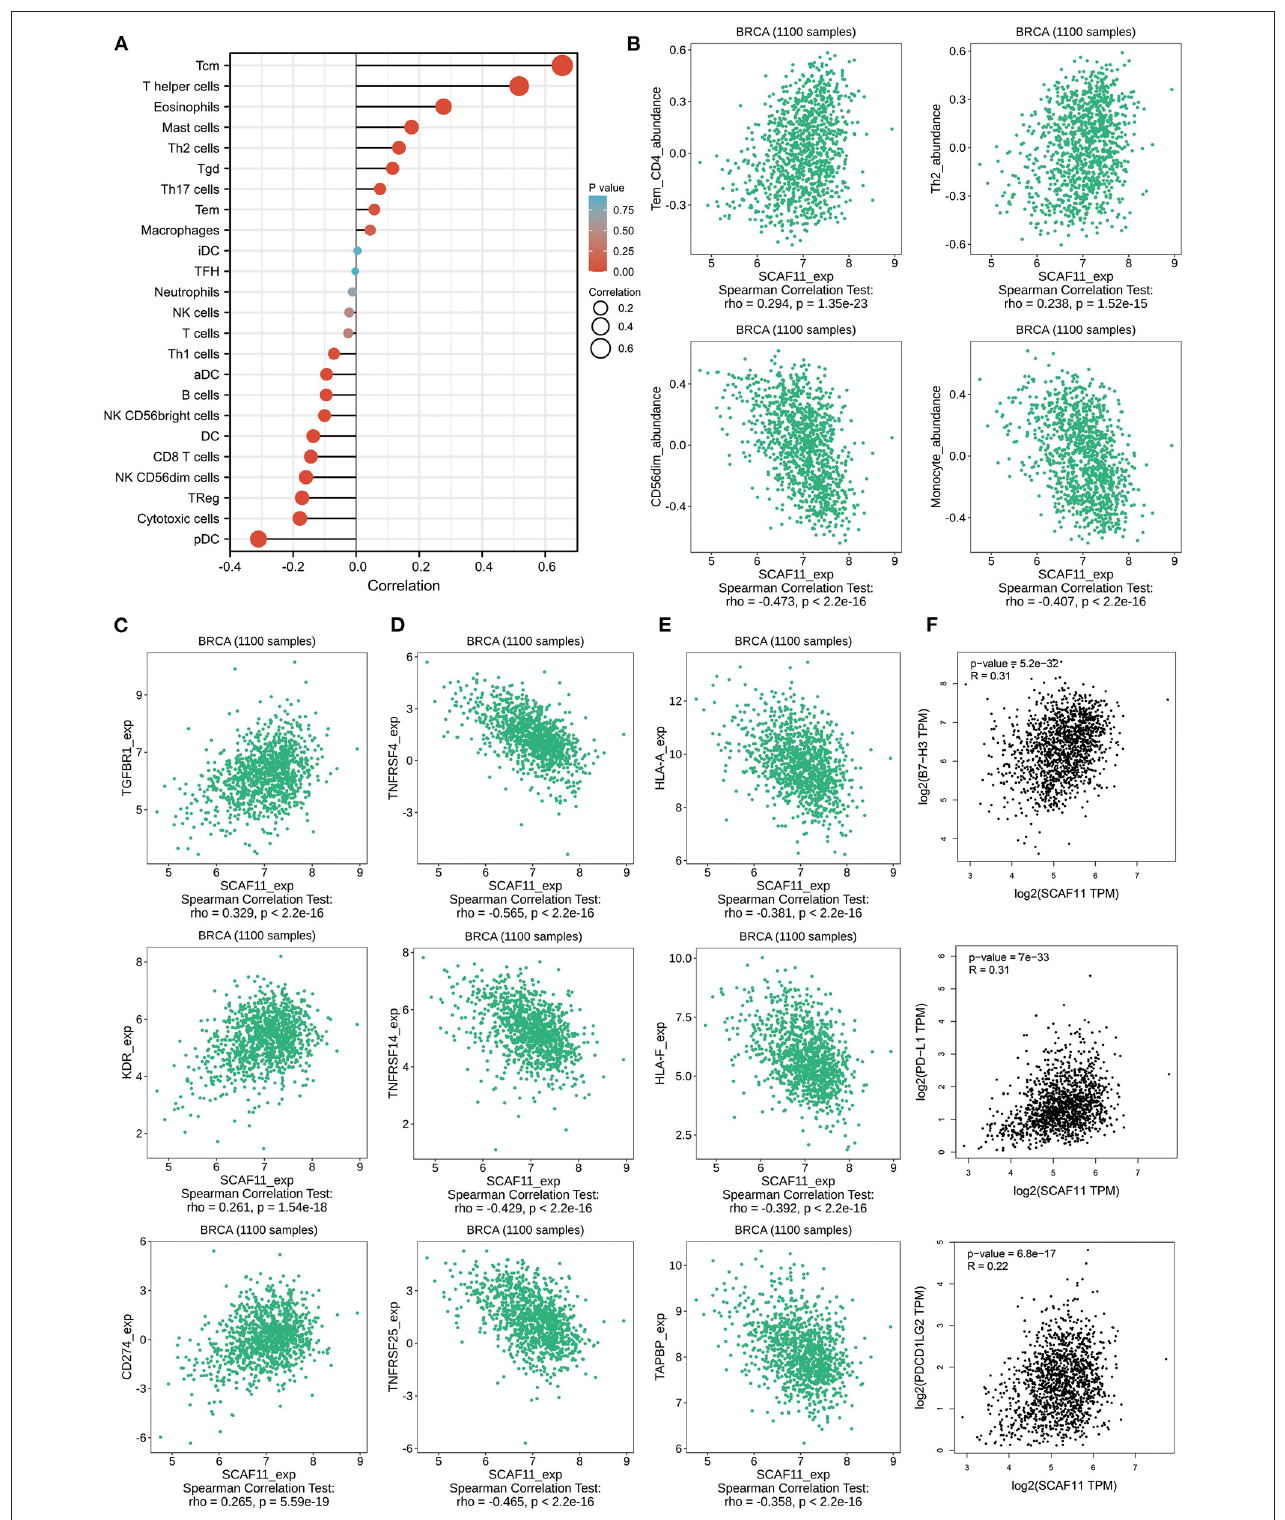
FIGURE 8 | The relationships between immune cell infiltration with SCAF11. (A) Immune infiltration cells associated with SCAF11 by Xiantao tool. (B) Validations of partial lymphocytes by the TISIDB database. Associations of SCAF11 expression with immunoinhibitors (C) , immunostimulators (D) , and MHC molecules (E) . (F) The association between SCAF11 with PD-L1, B7-H3, and PDCD1LG2.